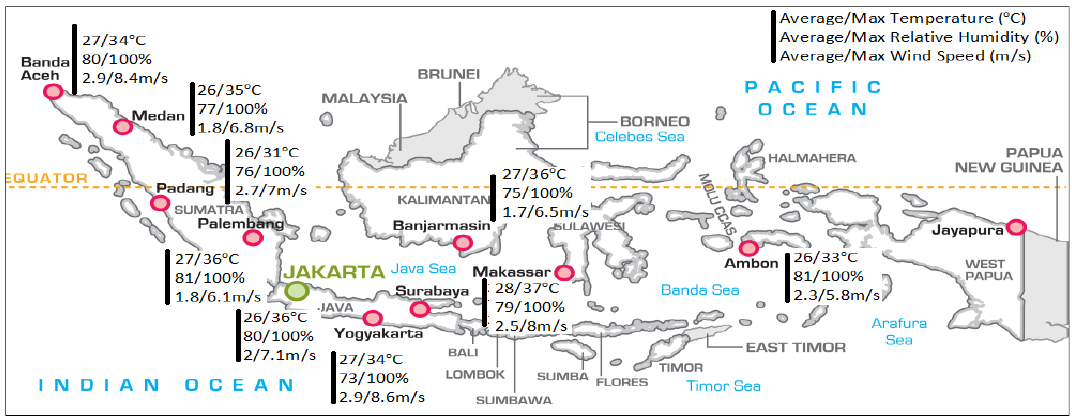
Figure 1. Map of Indonesia with temperature, relative humidity and wind speed (blank Indonesian map from [3]).